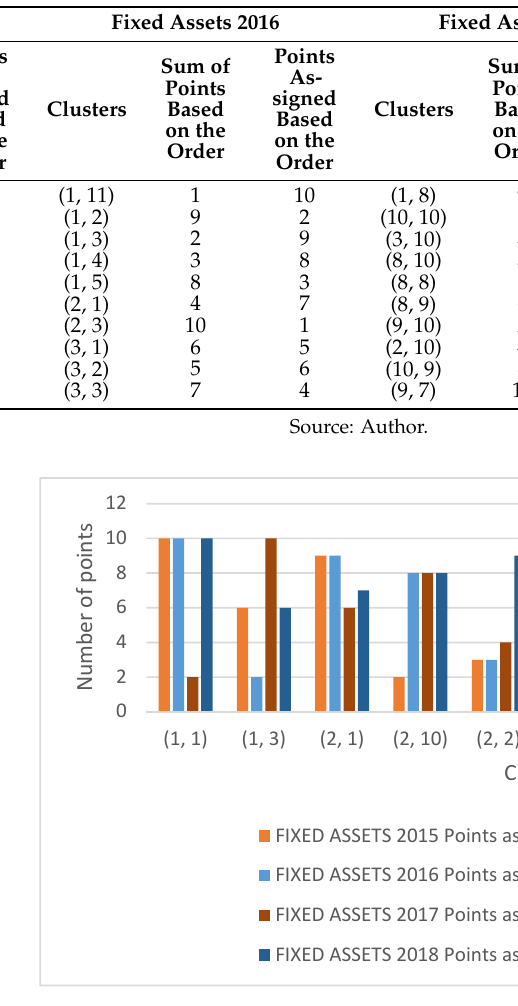
Table 26. Evaluation of clusters based on their order—years 2015–2018 (Fixed Assets).